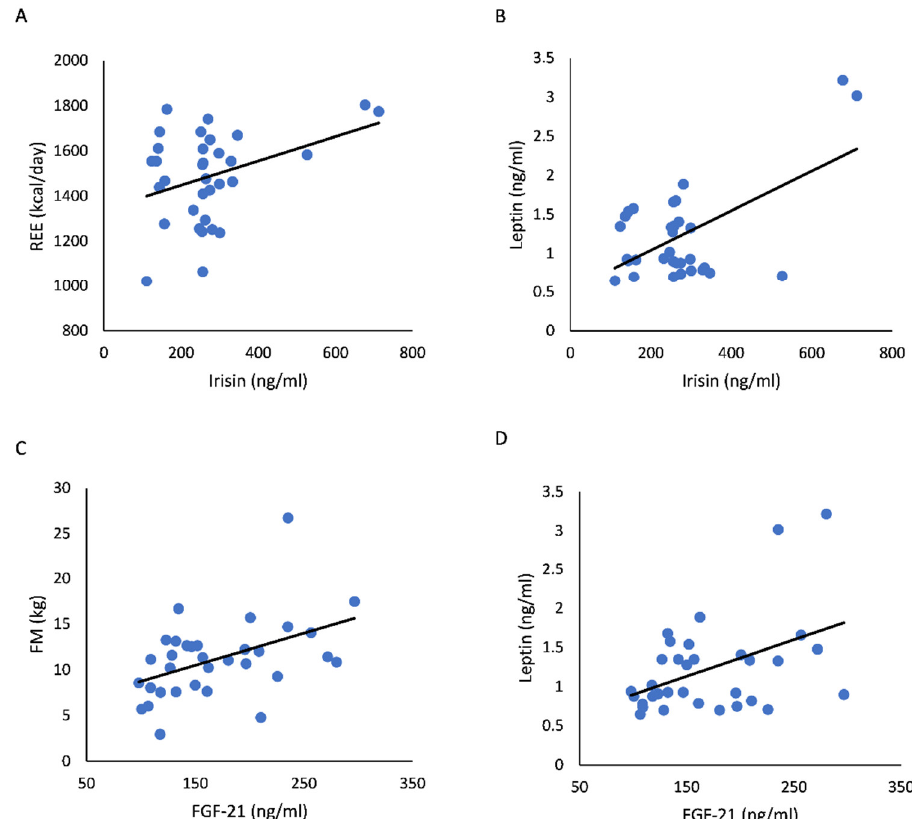
Figure 1. Relationships of irisin levels with resting energy expenditure (REE) ( A ) ( r = 0.40; p = 0.021) and leptin ( B ) ( r = 0.60; p < 0.0001), and relationships of fibroblast growth factor-21 (FGF-21) with body fat mass (FM) ( C ) ( r = 0.46; p = 0.007) and leptin ( D ) ( r = 0.45; p = 0.009) in rhythmic gymnasts.